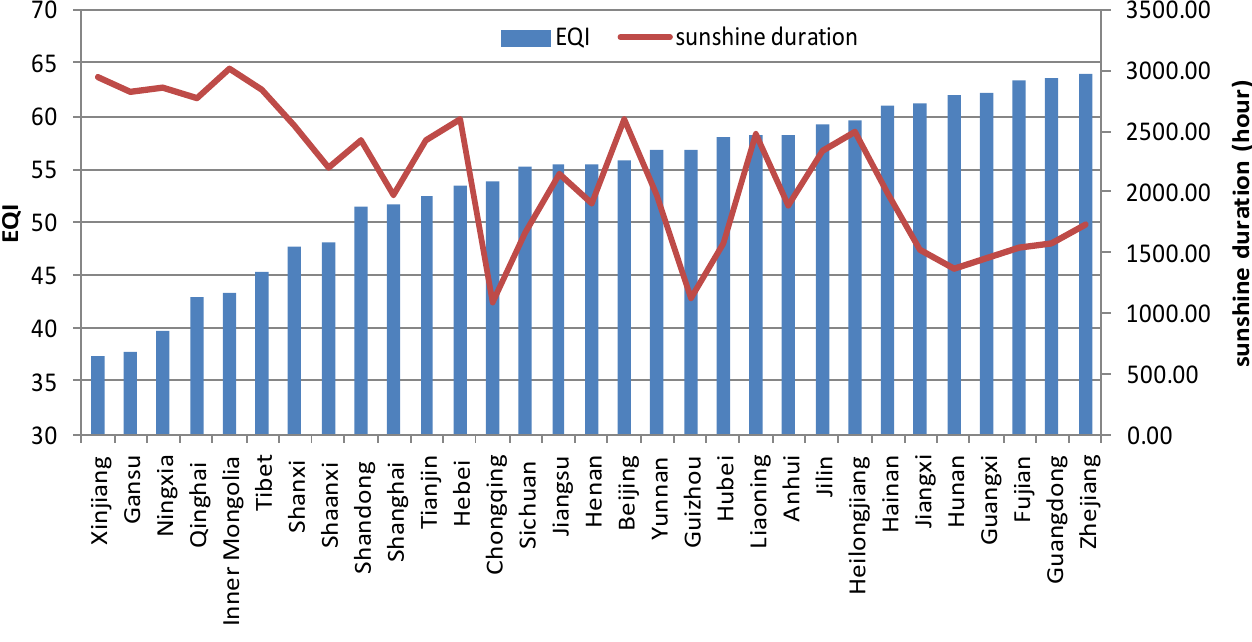
Figure 9. Best-fit curve for EQI and sunshine duration in 2005.